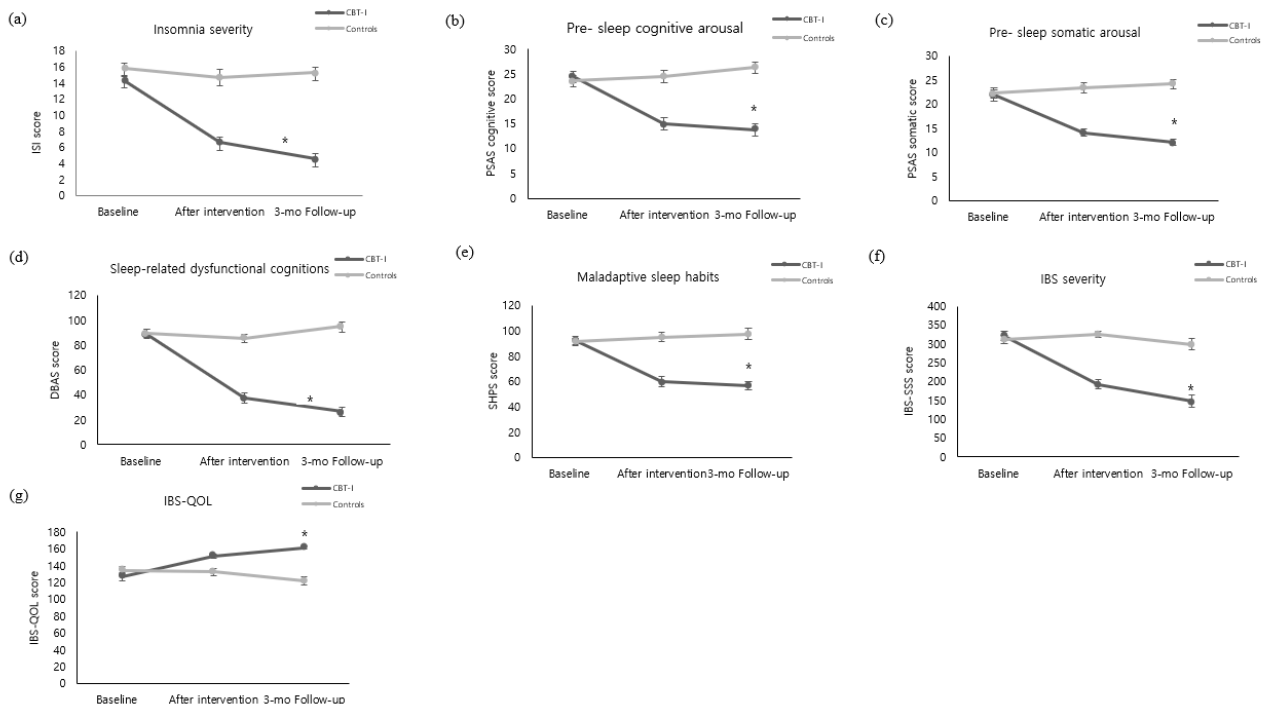
Figure 2. Comparison of outcome variables of the experimental and control groups over time (( a ) Insomnia severity. ( b ) Pre-sleep cognitive arousal. ( c ) Pre-sleep somatic arousal. ( d ) Sleep-related dysfunctional cognitions. ( e ) Maladaptive sleep habits. ( f ) IBS severity. ( g ) IBS-QOL). The p value was calculated using repeated measured ANOVA. CBI-I: Cognitive behavioral therapy for insomnia. ISI: Insomnia Severity Index. PSAS: Pre-Sleep Arousal Scale. DBAS: Dysfunctional Beliefs and Attitudes about Sleep Scale. SHPS: Sleep Hygiene Practices Scale. IBS: Irritable Bowel Syndrome. IBS-QOL: Irritable Bowel Syndrome-Quality of Life. * p <